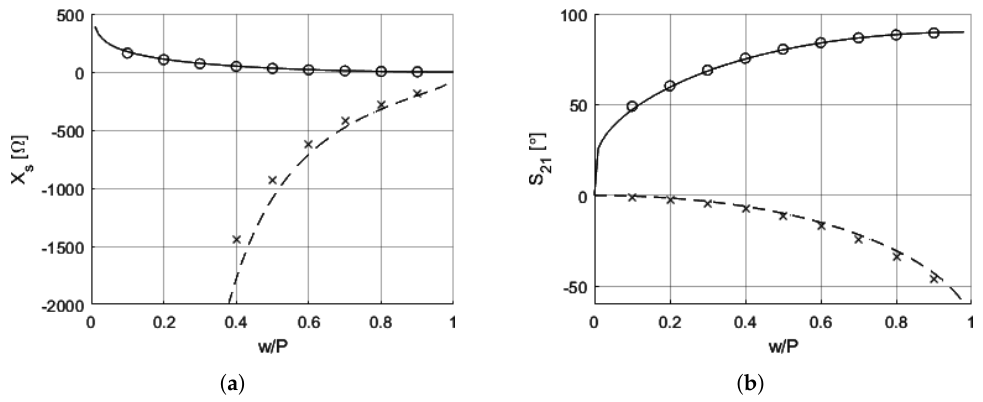
Figure 6. Performance of strip unit cells. Lines are analysis, points simulation results. Solid and circles—parallel strip; dashed and crosses—perpendicular strip. ( a ) Surface reactance; ( b ) phase shift.